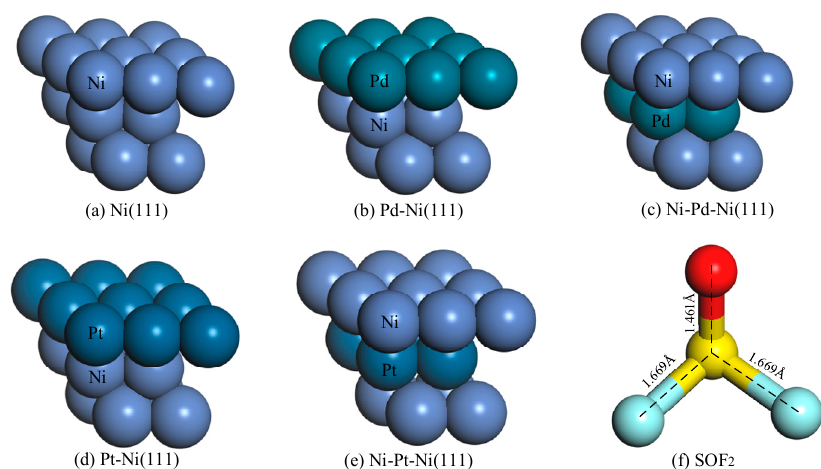
Figure 1. ( a – e ) Structures of the Ni(111) monometallic and Pd/Pt-Ni(111) bimetallic surfaces, ( f ) Figure1. ( a – e )StructuresoftheNi(111)monometallicandPd / Pt-Ni(111)bimetallicsurfaces, ( f )Structure Structure of SOF 2 . of SOF 2 .